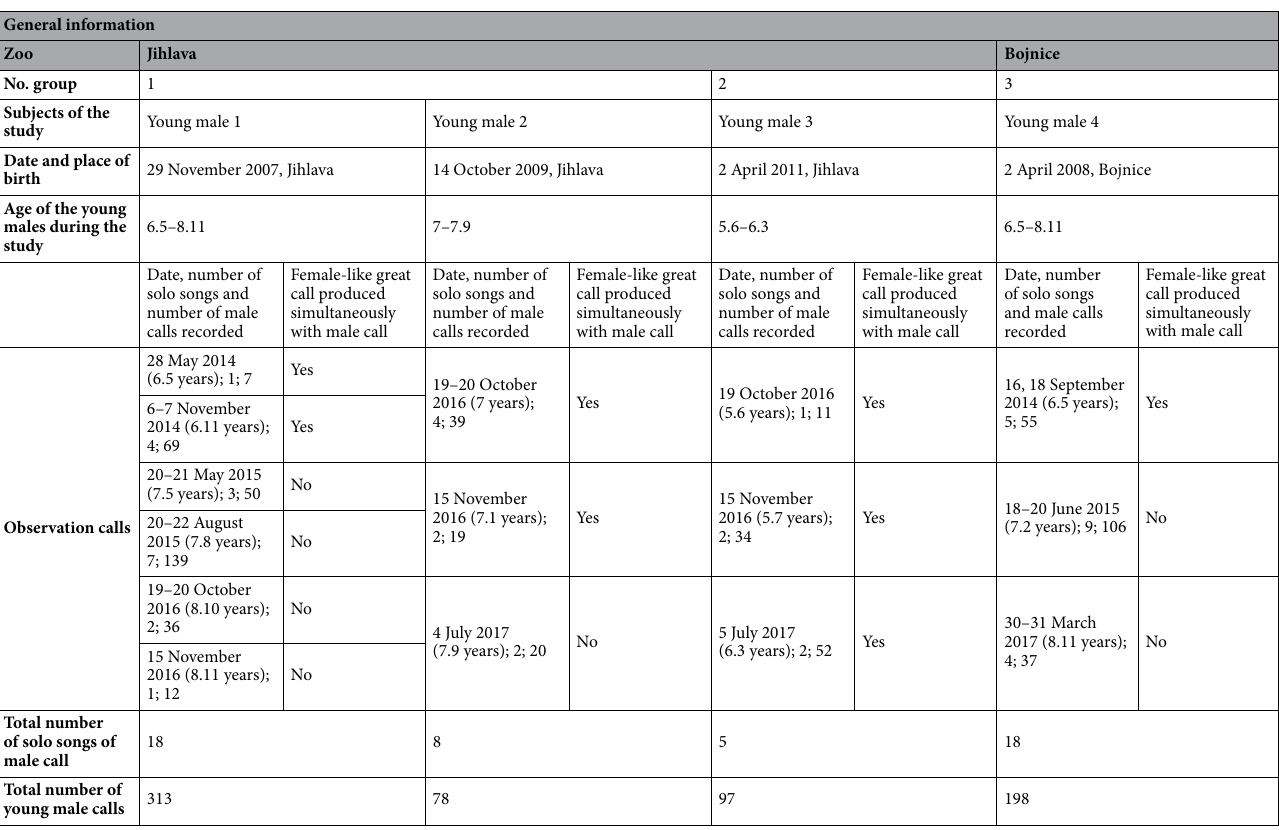
Table 1. Overview of southern yellow-cheeked gibbon males and the composition of the family